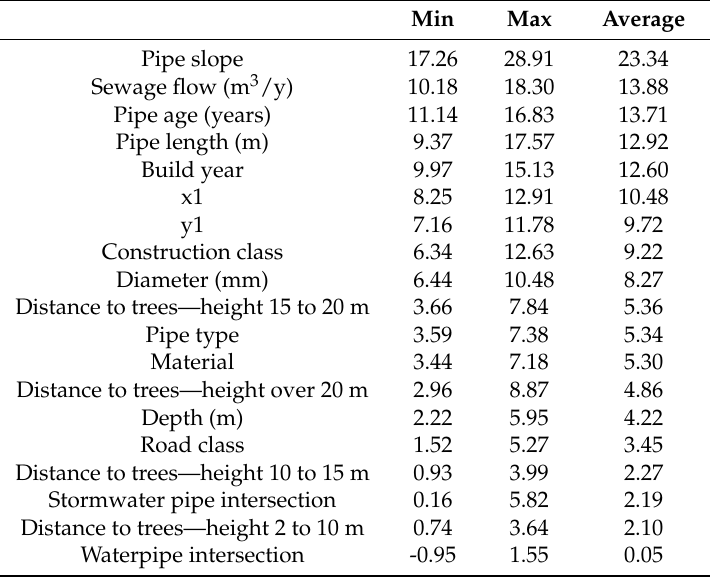
Table 4. Variable importance according to the Boruta